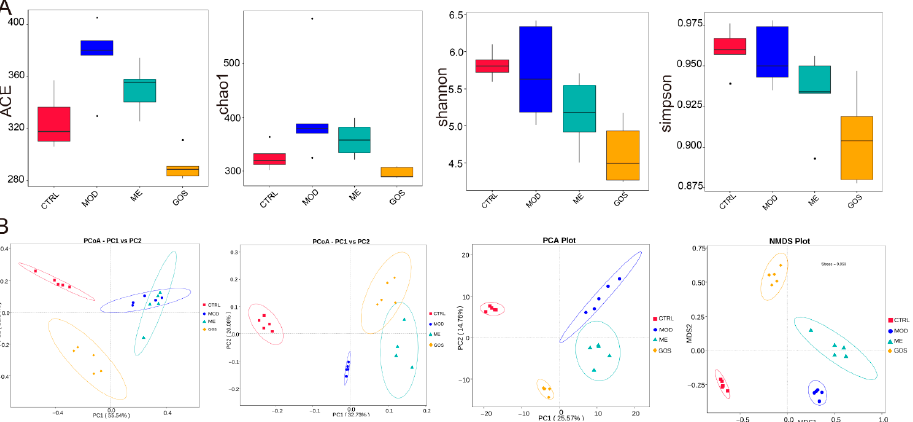
Figure 9. ( A ) Comparison of differences between groups of alpha diversity index. ( B ) Dimensionality reduction analysis results of beta diversity of mice in each group. Analysis of the Effect of GOS on Different Species of Intestinal Microbial Colonies in NAFLD Mice To study the different species between the groups at the genus level, a t test between groups was carried out. As shown by the results in Figure 10A,B compared with the model group, the GOS group showed significantly upregulated levels of Bifidobacterium , Bac- teroides , and Parabacteroides in the fecal samples. Additionally, GOS treatment significantly